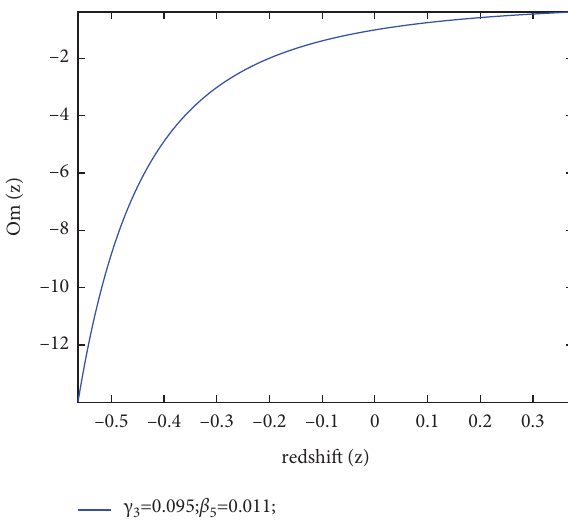
Figure 30: Om-diagnostics (Om( z )) versus. redshift ( z ) for